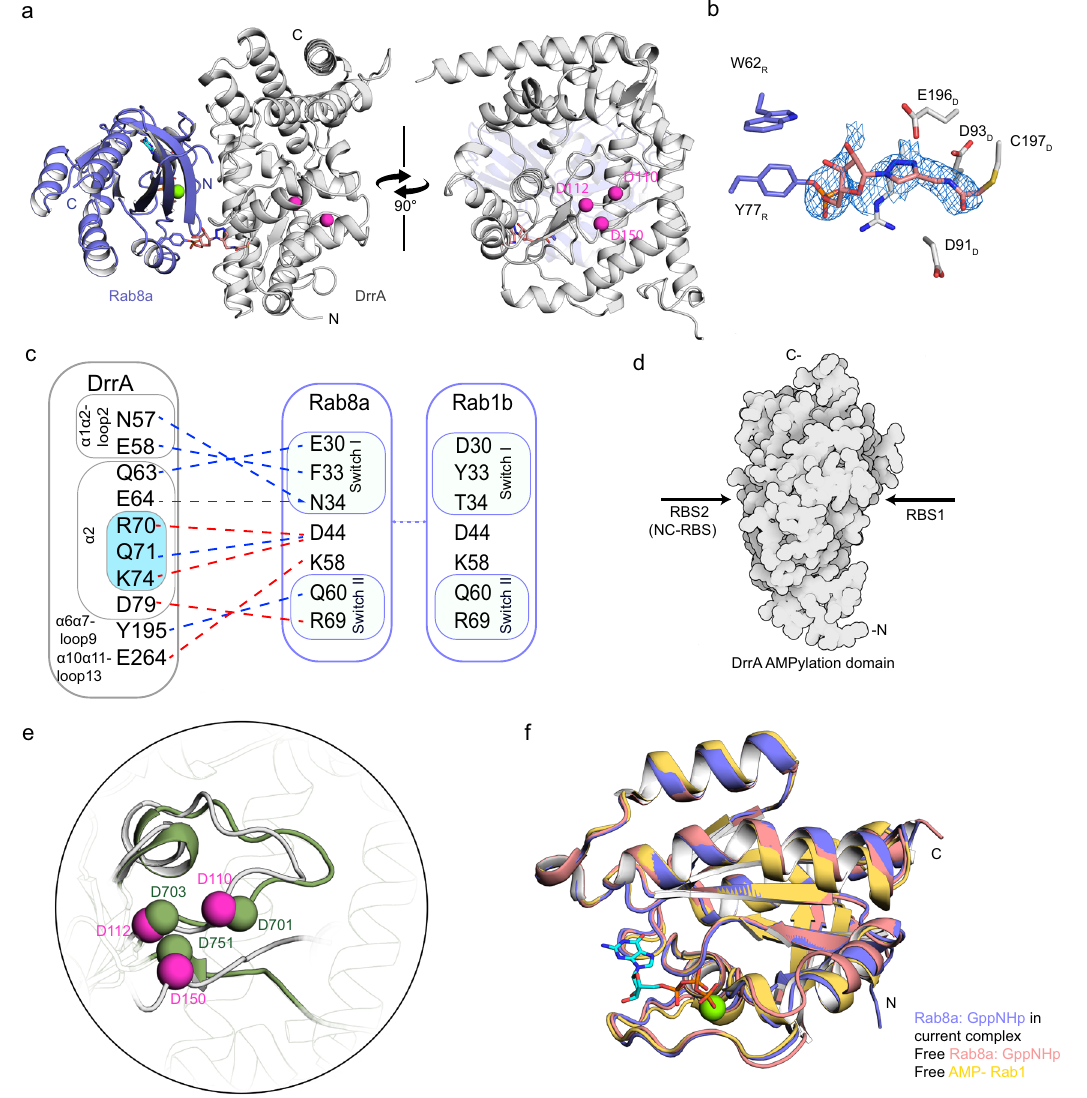
Fig. 2 Structure of the DrrA:Rab8a complex. a Orthogonal views of the Rab8-DrrA complex. Pink spheres denote the catalytic Asp residues of DrrA. The green sphere represents the Mg 2 + ion. b Linker density from the unbiased simulated-annealing omit D Fo-Fc electron density map contoured at 2.5 σ . The R subscript denotes Rab8a, and the D subscript denotes DrrA. c Schematic representation of the Rab8-DrrA interface. Interactions are shown with dashed lines; hydrogen bonds are blue and salt bridges are red. The corresponding interaction residues in Rab1 are shown in the panel on the right. Important residues for maintaining enzymatic activity are coloured cyan, and ‘ α ’ represents α -helix. d Demonstration of the conventional site (RBS1, containing the catalytic centre) and non-conventional site (RBS2, the back face of the catalytic centre. e Structural comparison between the catalytic centre in GS-ATase (PDB: 3K7D, green) and the catalytic centre in DrrA in the DrrA-Rab8a complex. The catalytic centre of DrrA includes D110 DrrA , D112 DrrA and D150 DrrA . The catalytic centre of GS-AT includes D701 GS-AT , D703 GS-AT and D753 GS-AT . f Structural superposition of free AMP-Rab1:GppNHp (PDB: 3NKV, yellow) and Rab8a (PDB: 4LHW, pink) with Rab8a (blue) from the complex with DrrA. Green spheres indicate Mg 2 + ions, and GppNHp is shown in stick